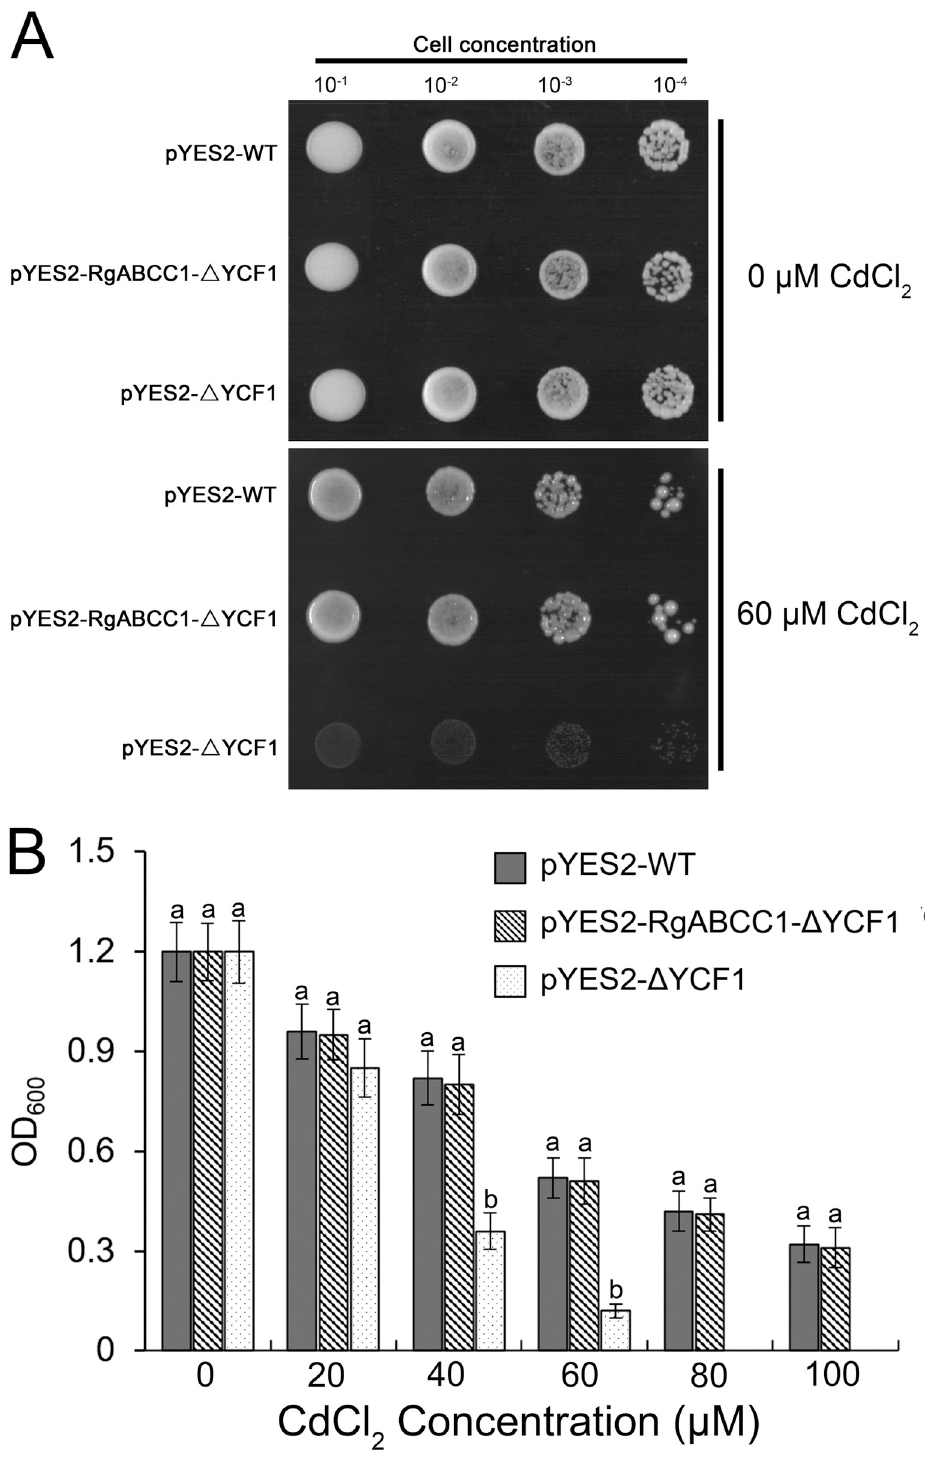
Fig 7. Cd tolerance analysis for RgABCC1 heterologous expression in the Δ YCF1 yeast mutant. (A) Drop assay of the strain expressing RgABCC1 on medium with 0 or 60 μ M CdCl 2 ; (B) Growth assay of the strain expressing RgABCC1 under CdCl 2 stress at various